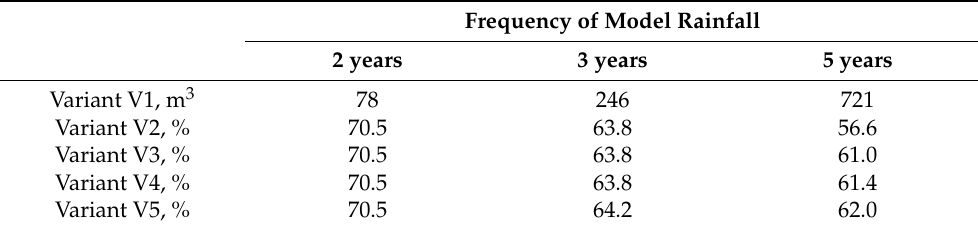
Table 8. Reduction of local flooding—summed up for the entire catchment area.